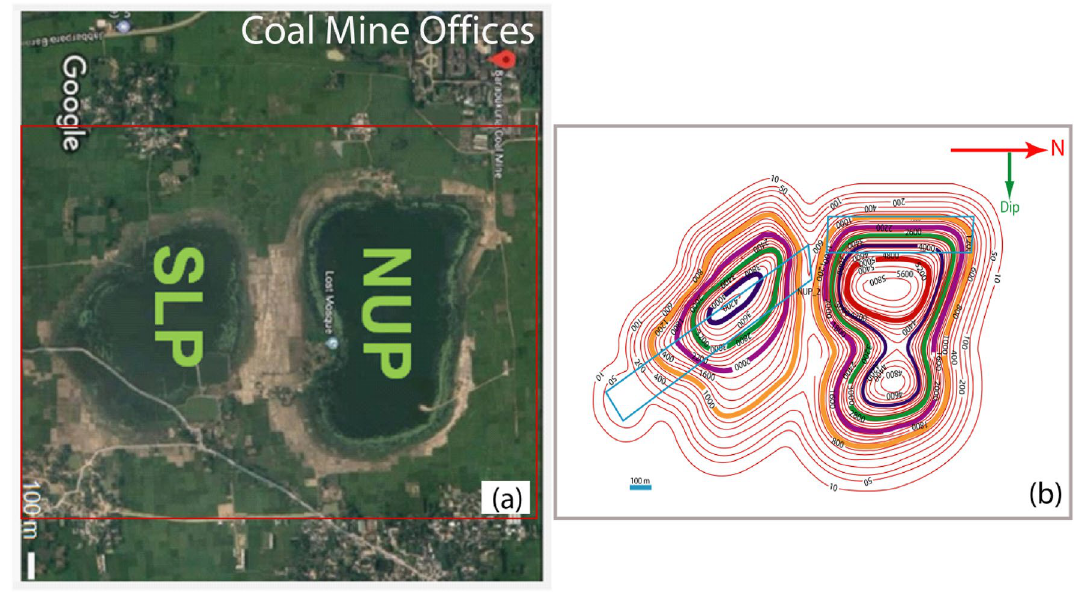
Figure 6. The subsidence in the Barapukuria coal mine area. ( a ) Subsidence epicenters (Google 22 image) ( b ) Subsidence (mm) contour (BCMCL 21 ). (Abobe Illustrator 10, https:// www. adobe. com/ produ cts/ illus trator.